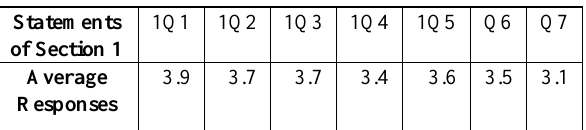
Table 3. The summary for TP responses to Section 1